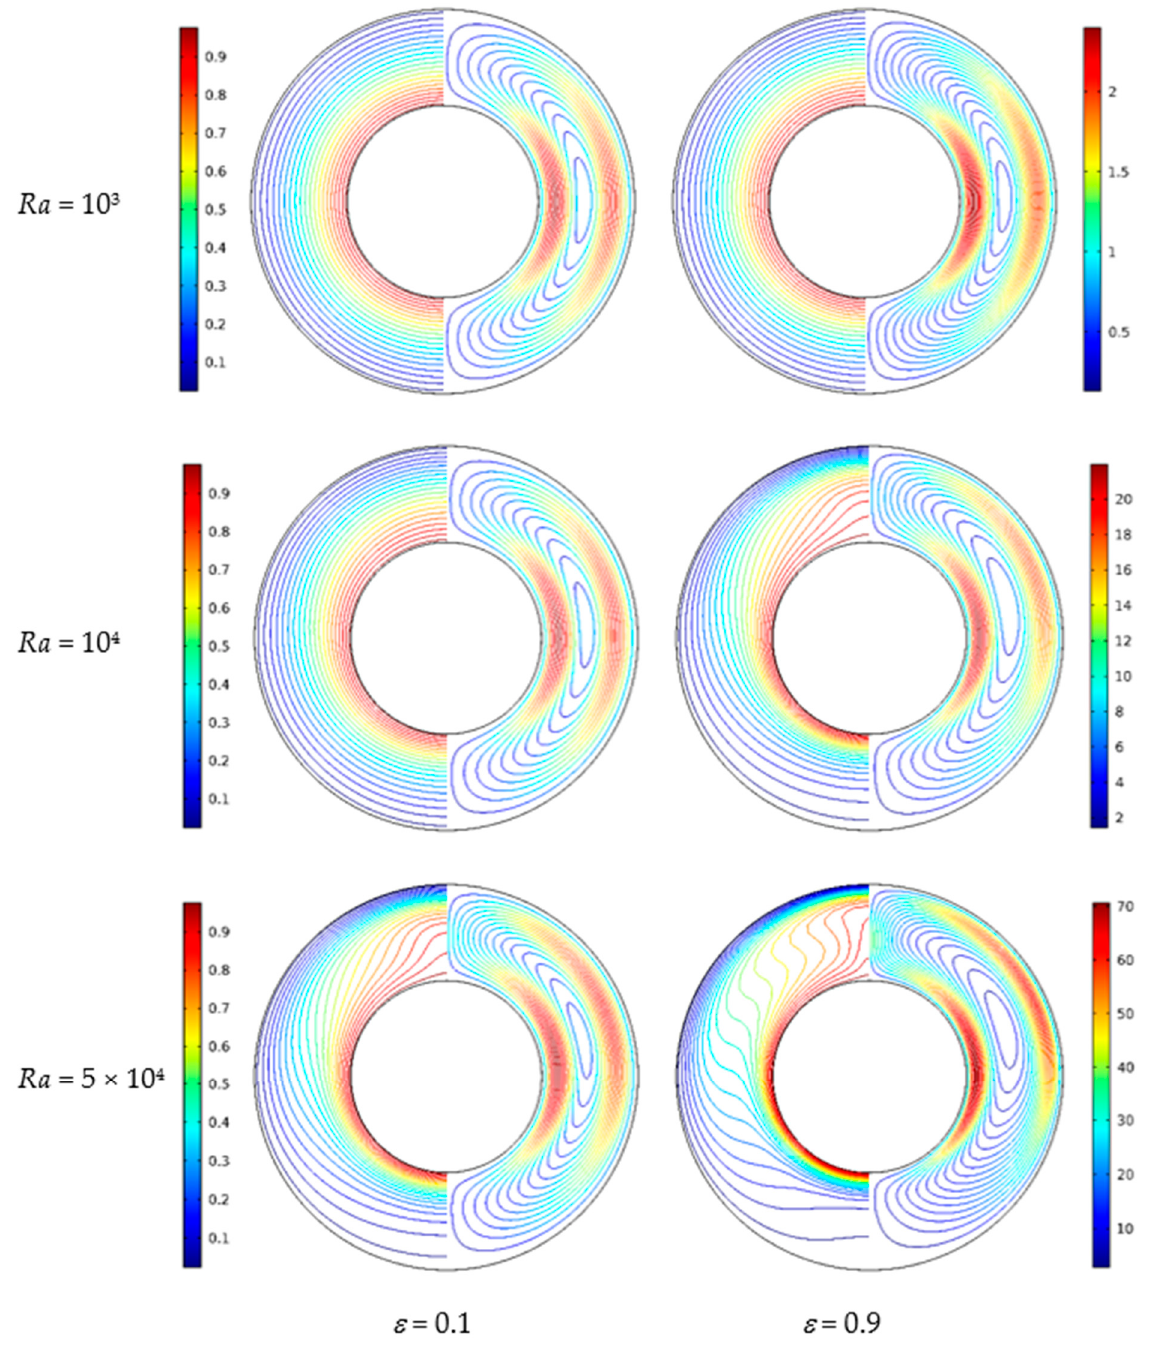
Figure 14. Isotherms (left) and streamlines (right) for Cu–water nanofluid for different porosity ( ε ) and Rayleigh numbers ( Ra ) at Da = 10 − 2 , φ = 0.05, d sp = 50 nm, and RR = 2.